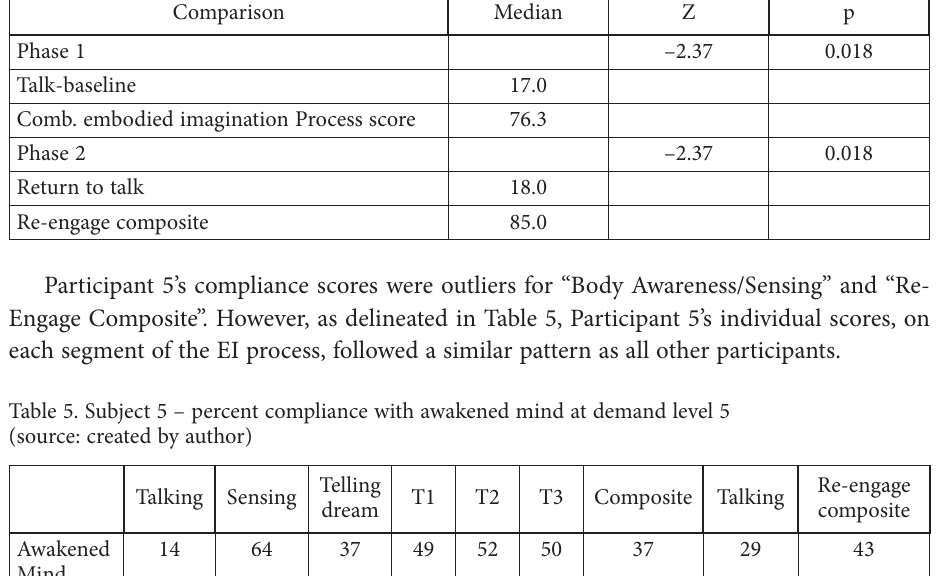
Table 4. Wilcoxon signed-rank test for matched pairs of awakened mind (source: created by author) Comparison Median Phase 1